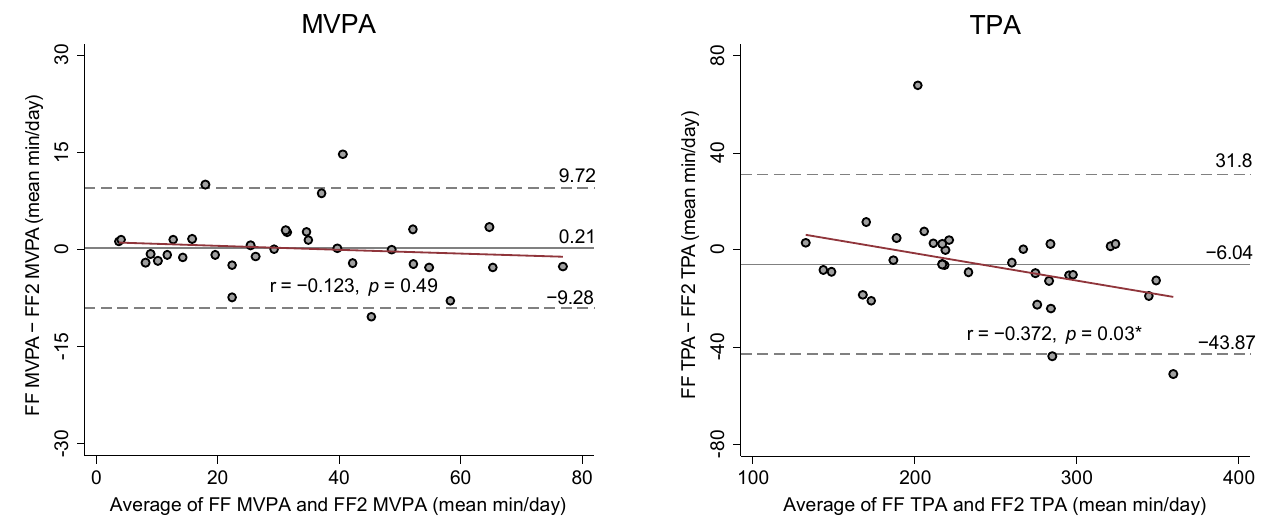
Figure 2. Bland-Altman plot comparing estimates of SED and PA between FF and FF2. Dashed lines show 95% limits of